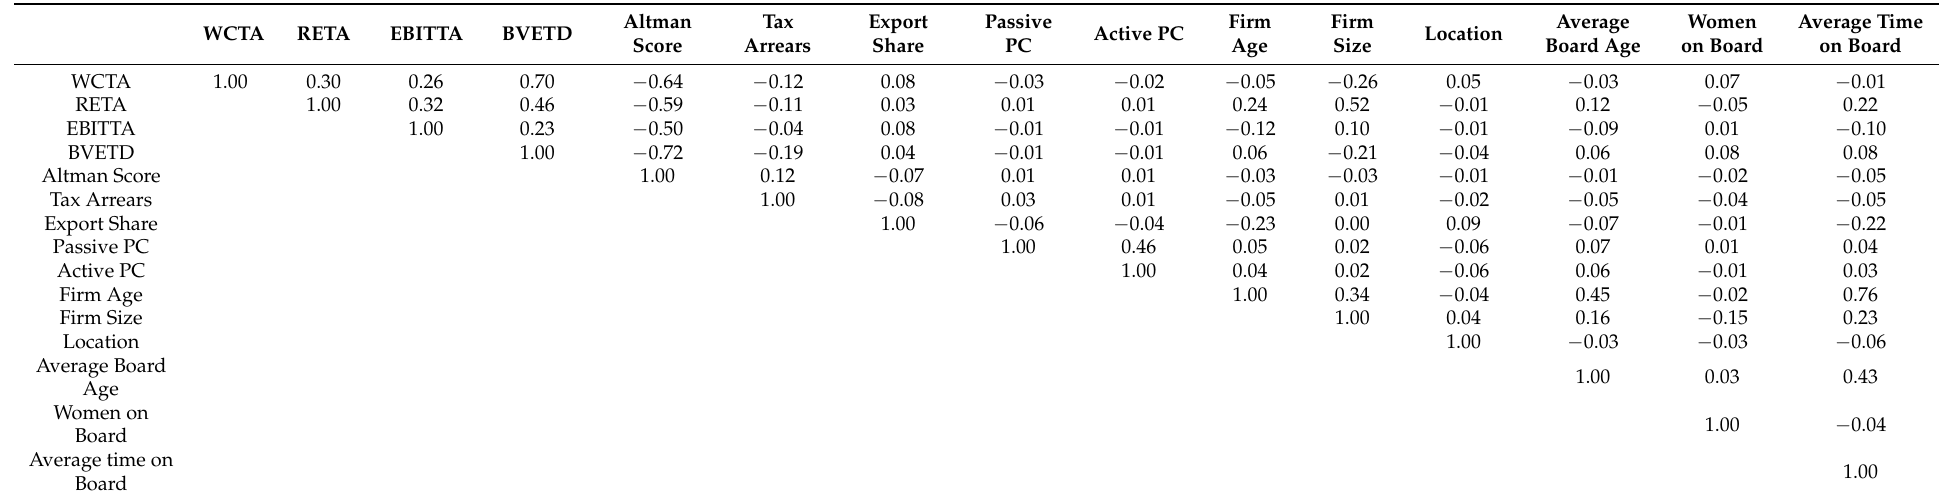
Table A5. Correlation